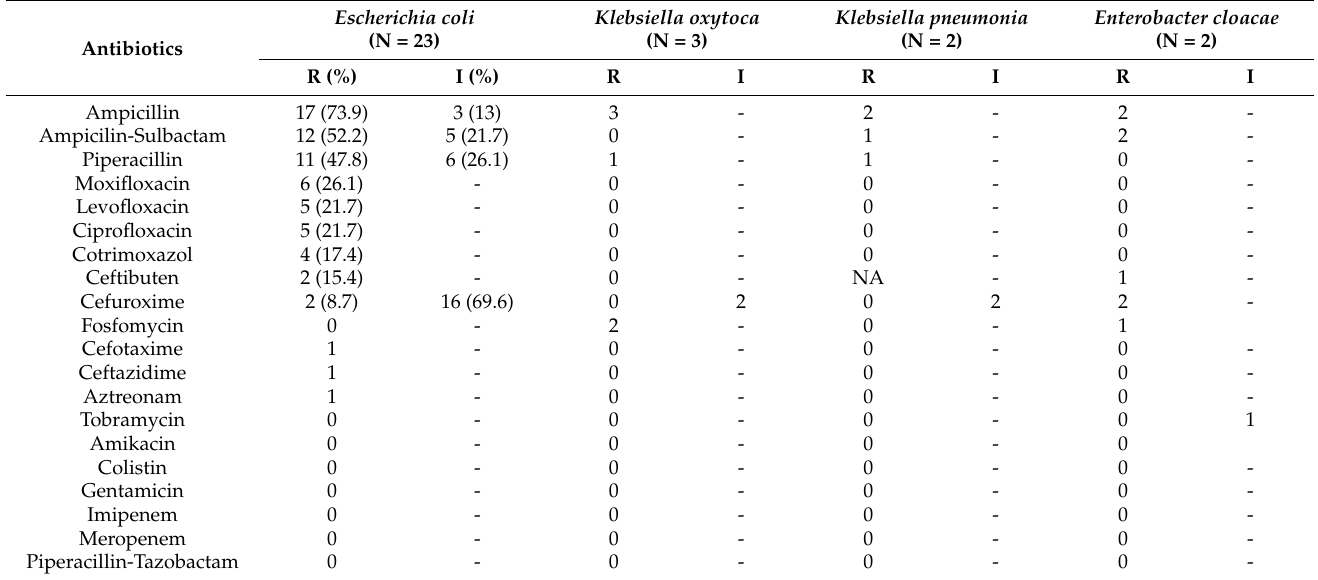
Table 4. Antibiotic resistance patterns of predominant gram negative bacterial isolates from neonatal sepsis patients, 2012–2020.